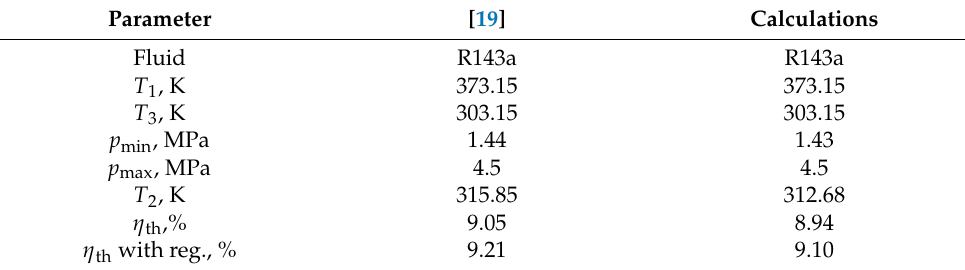
Table 6. Main parameters of organic Rankine cycles.